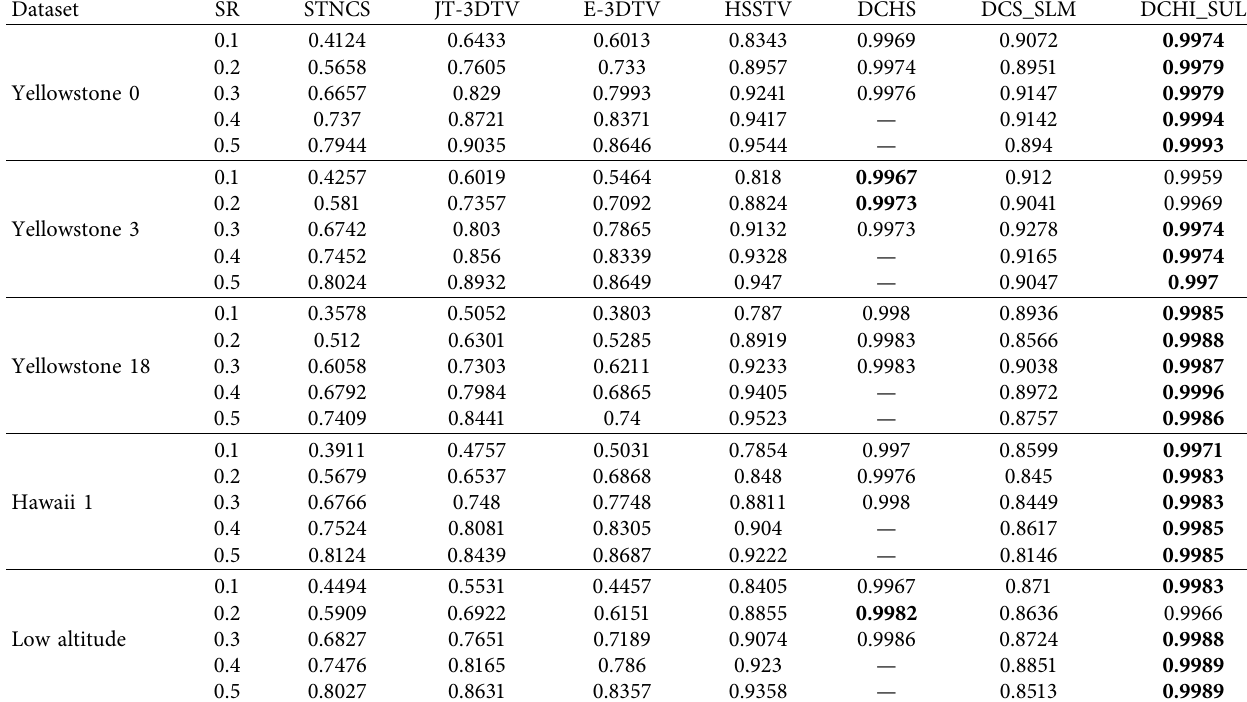
Table 2: MSSIM comparison of all competing methods under different sampling rates on five